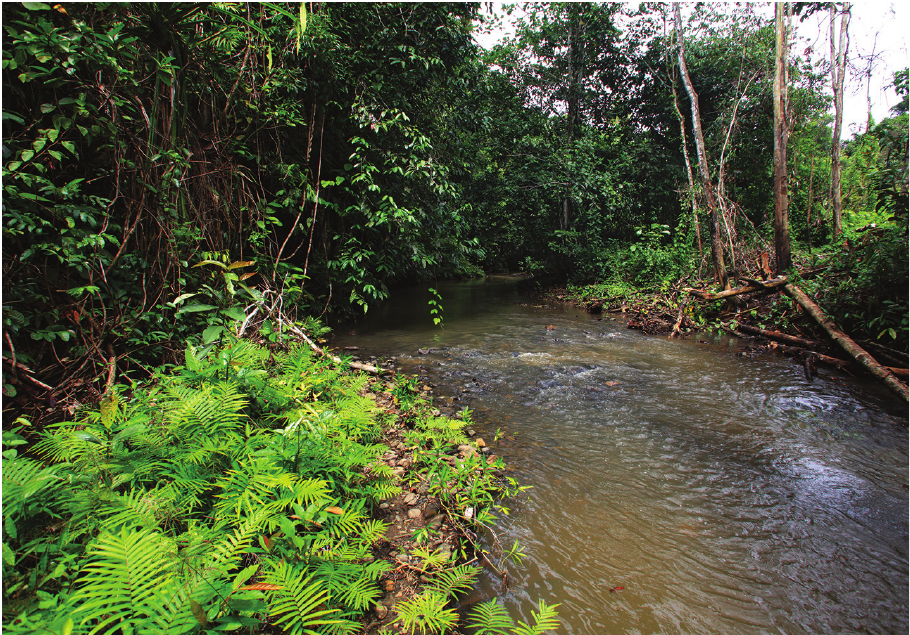
Figure 10. Tributary to the Warsamson River, habitat of the new